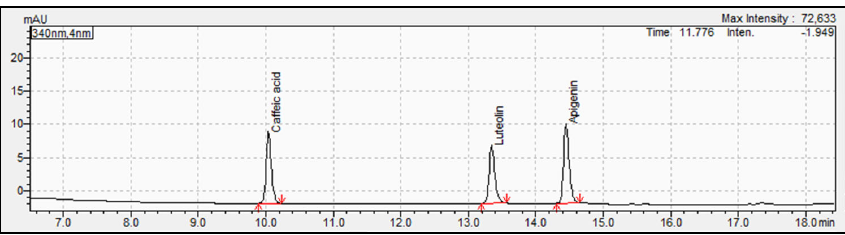
Figure 2. Representative chromatogram acquired for standard solution of caffeic acid, luteolin and apigenin at 340 nm.